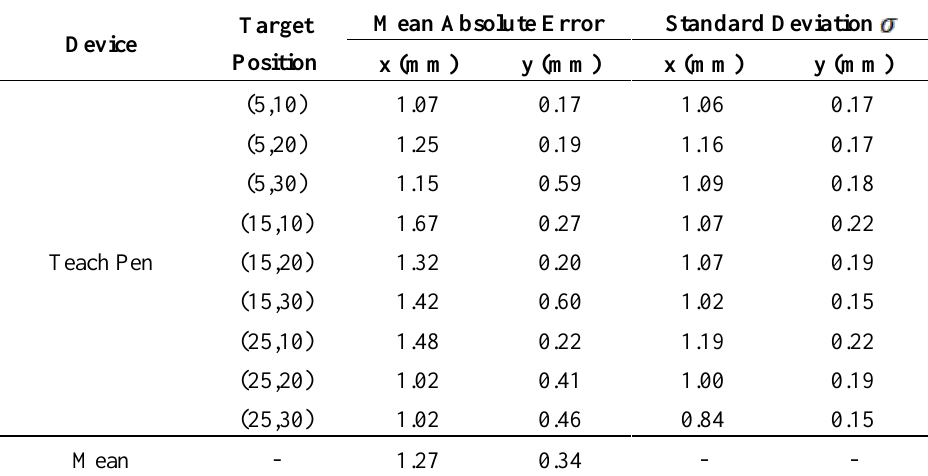
Table 1. Bias and variance in the experimental